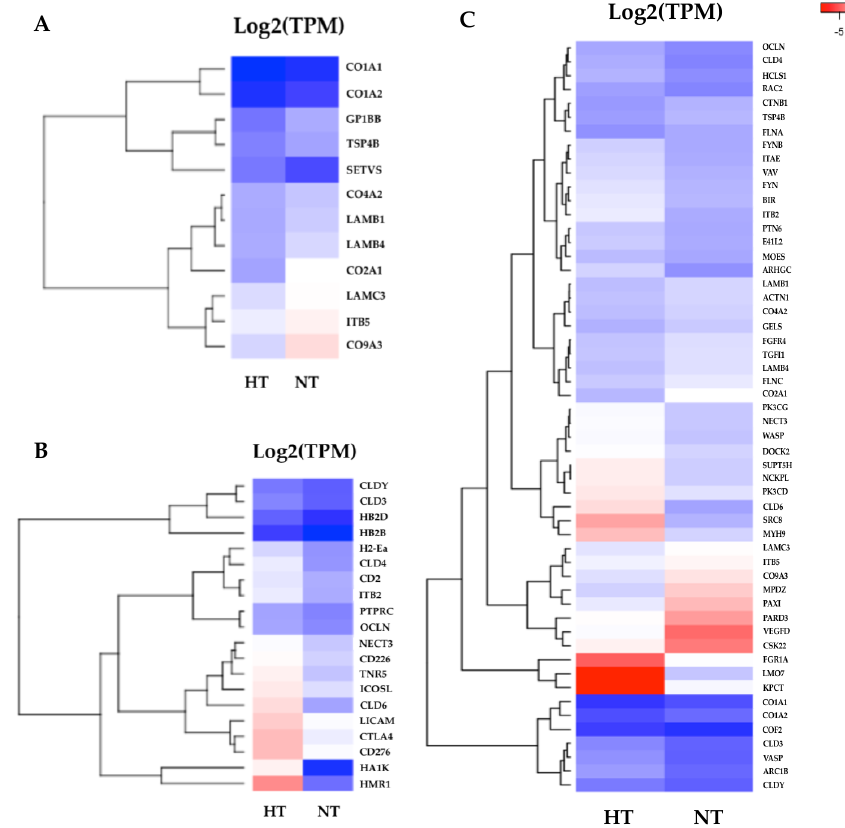
Figure 5. Heatmaps of specific enriched pathways in the gill tissues. ( A ) Twelve DEGs of the extracellular matrix (ECM)–receptor interaction were highly expressed in the HT group and were divided into two major clusters. ( B ) Twenty DEGs of cell adhesion molecules (CAMs). ( C ) 54 DEGs were identified in the gill tissues, most of which were associated with cell junction and the adhesion pathway. The red indicates less expressed DEGs, and the blue indicates highly expressed DEGs when comparing the HT and NT